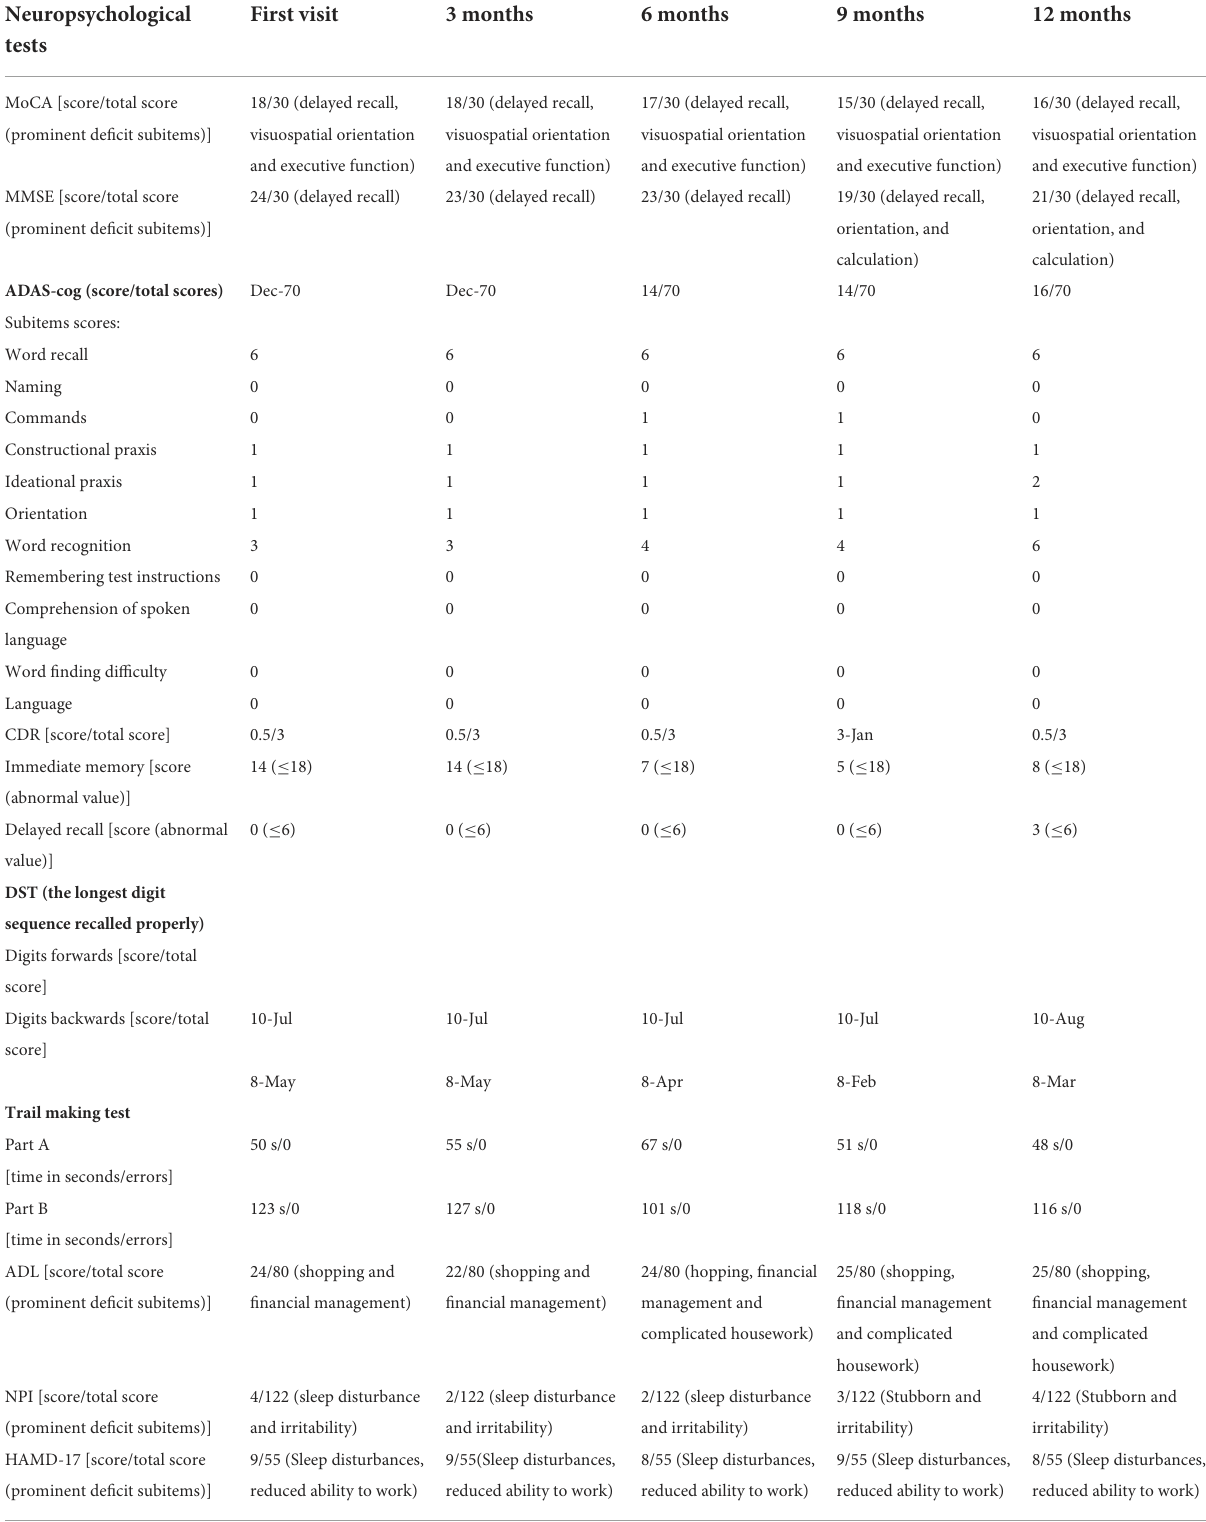
TABLE 1 Neuropsychological scale outcomes for the first visit and follow-up.